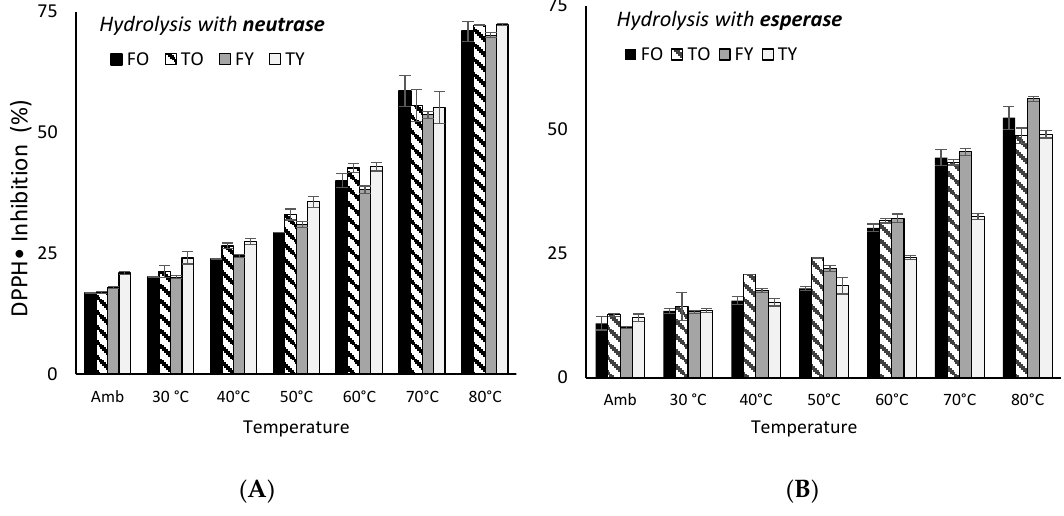
Figure 4. Highest and lowest DPPH • inhibition (%) for collagen peptides solutions ( < 3000 Da) obtained through neutrase ( A ) and esperase ( B ), respectively, and at increasing temperatures. FO = old femur, 10 years; TO = old tibia, 10 years; FY = young femur, 4.5 years; TY = young tibia, 4.5 years.